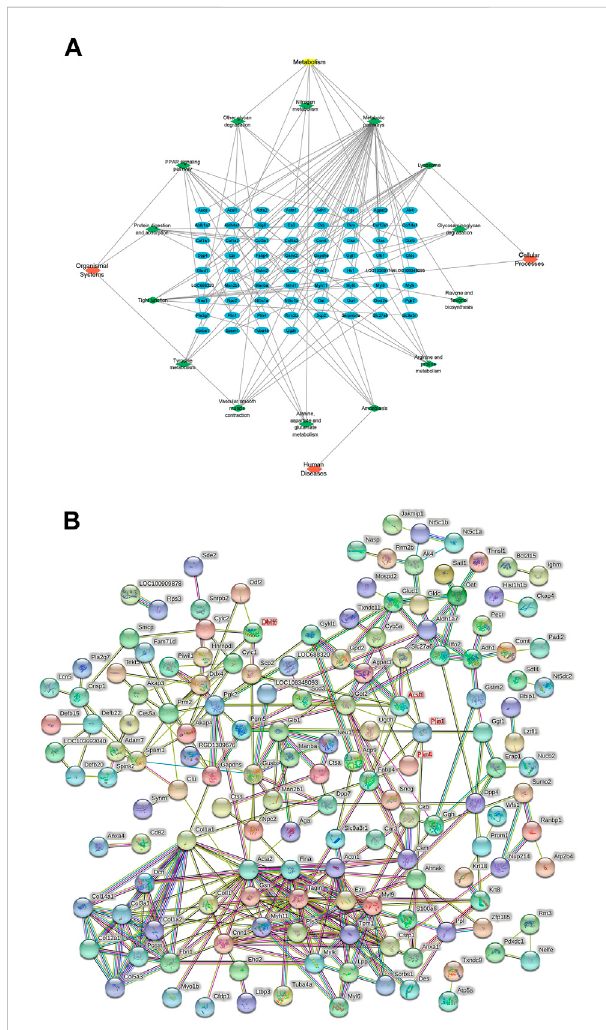
FIGURE 5 (A) KEGG pathway network diagram of the treatment and model groups. The blue graphs represent DEPs, the green graphs represent pathways, and the red graphs represent the types of pathways. (B) PPI analysis between differentially expressed